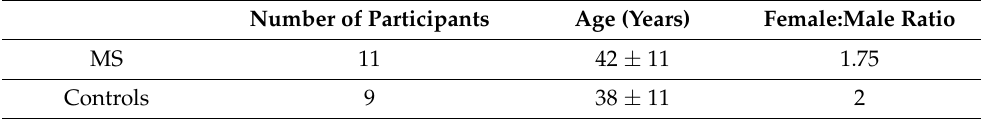
Table 3. Study participant demographic data (TAAR1 expression in CD14+ monocytes